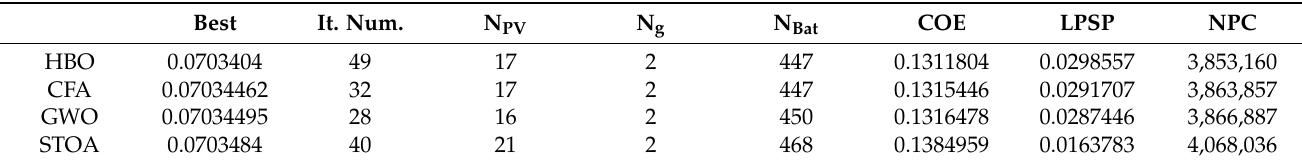
Table 7. The optimization properties for the proposed hybrid system based on using HBO, CFA, GWO and STOA for an isolated PV/Biomass/Bat.